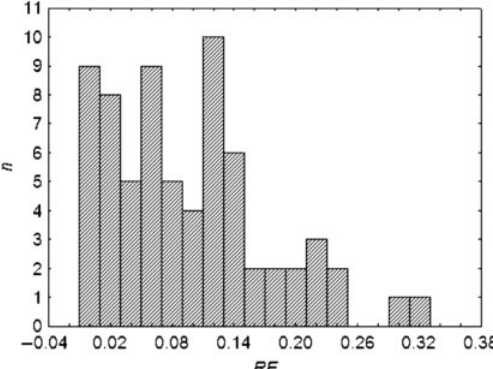
Fig. 18. Bar chart of relative error of pull-off adhesion f b and f c , b for neural network experimental